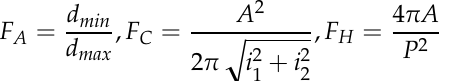
( f ) Figure 7. Real images of tested samples ( a–c ), grains with 0.75 mm granularity fraction ( d–f ). Edge-based methods are suitable to detect step changes in the images, especially linear and points features. Figure 8a presents two grains from the same sample that show a significant difference between boundaries. The one on the left is sharp, the right irregular. The results of processing of the raw images by edge detection operators are extremely sensitive to image noise levels; thus, images are smoothened with Gaussian and detected with Canny (Figure 8b). The boundary of the left grain is accurate, while the right is irregular. However, the edge separates the region of the right grain from the background and also sets it apart from the left grain.